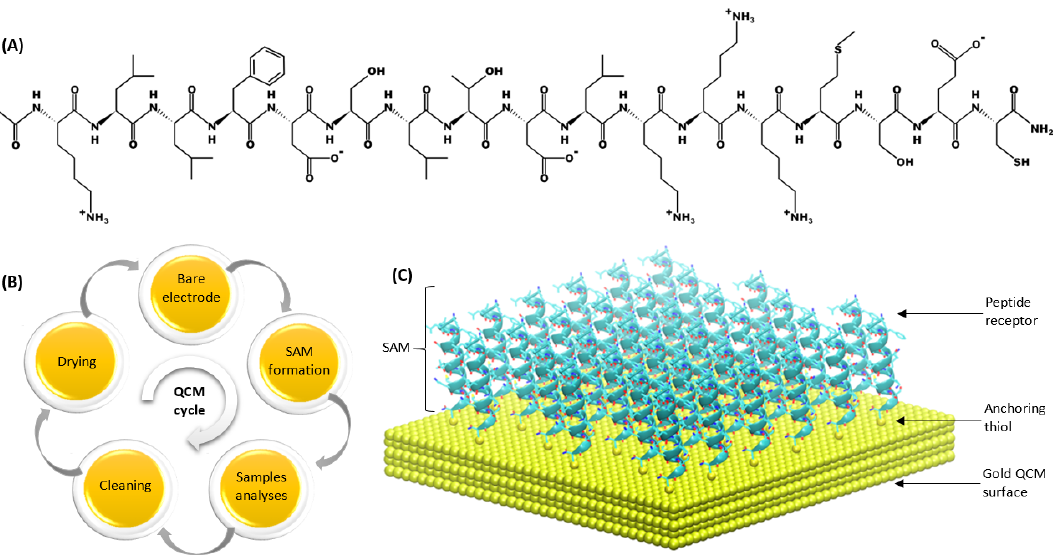
Figure 1. ( A ) Structure of peptide ( KLLFDSLTDLKKKMSEC-NH 2 ) used for SAM formation; ( B ) diagram of peptide-based QCM biosensor life-cycles; ( C ) schematic organization of a peptide SAM on one side of the gold QCM electrode.